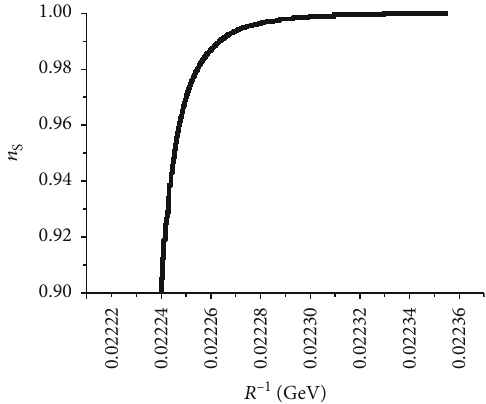
= 0 : 45 ð GeV Þ − 1 , ω = 4 : 6 ð GeV Þ , 0